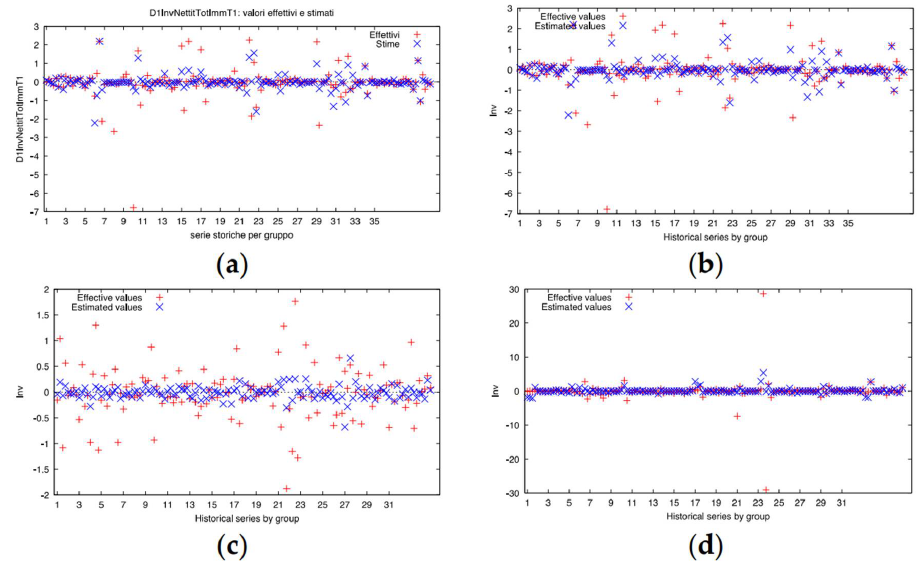
Figure 1. Graph for homoscedasticity: ( a ) northwest; ( b ) northeast; ( c ) centre; ( d ) south and